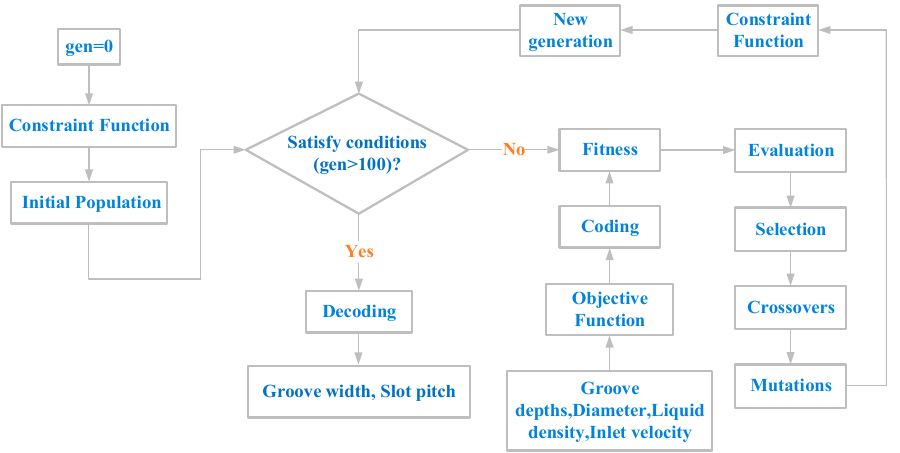
Figure 6. BSCN optimization flow chart.